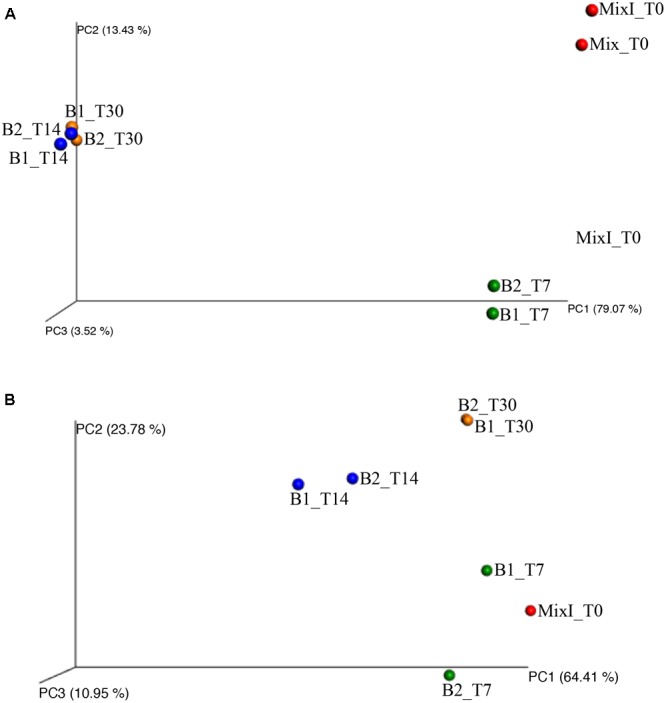
Principal coordinates analysis of weighted UniFrac distances for bacterial (A) and archaeal (B) 16S rRNA gene sequence data of samples during the incubation process. Color label. red: mixture of cheese whey and buttermilk at day 0 of incubation; green: samples collected after 7 days of incubation; blue: samples collected after 14 days of incubation; orange: samples collected after 30 days of incubation.